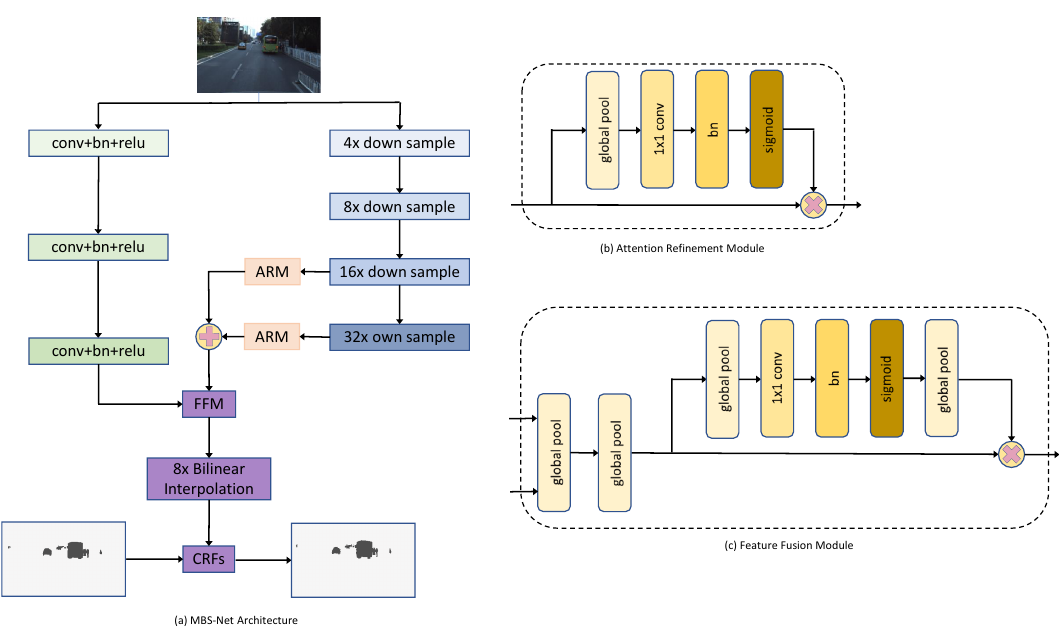
Figure 2. Overview of MBS-Net Architecture. (a) MBS-Net Structure including temporal regulation; (b) attention refinement module structure (c) feature fusion module